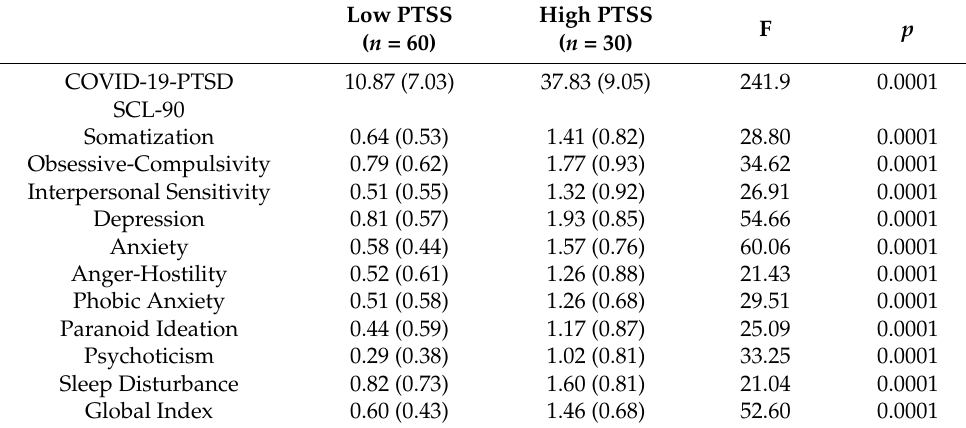
Table 2. Mean and standard deviation in the psychological variables of the two groups of participants.